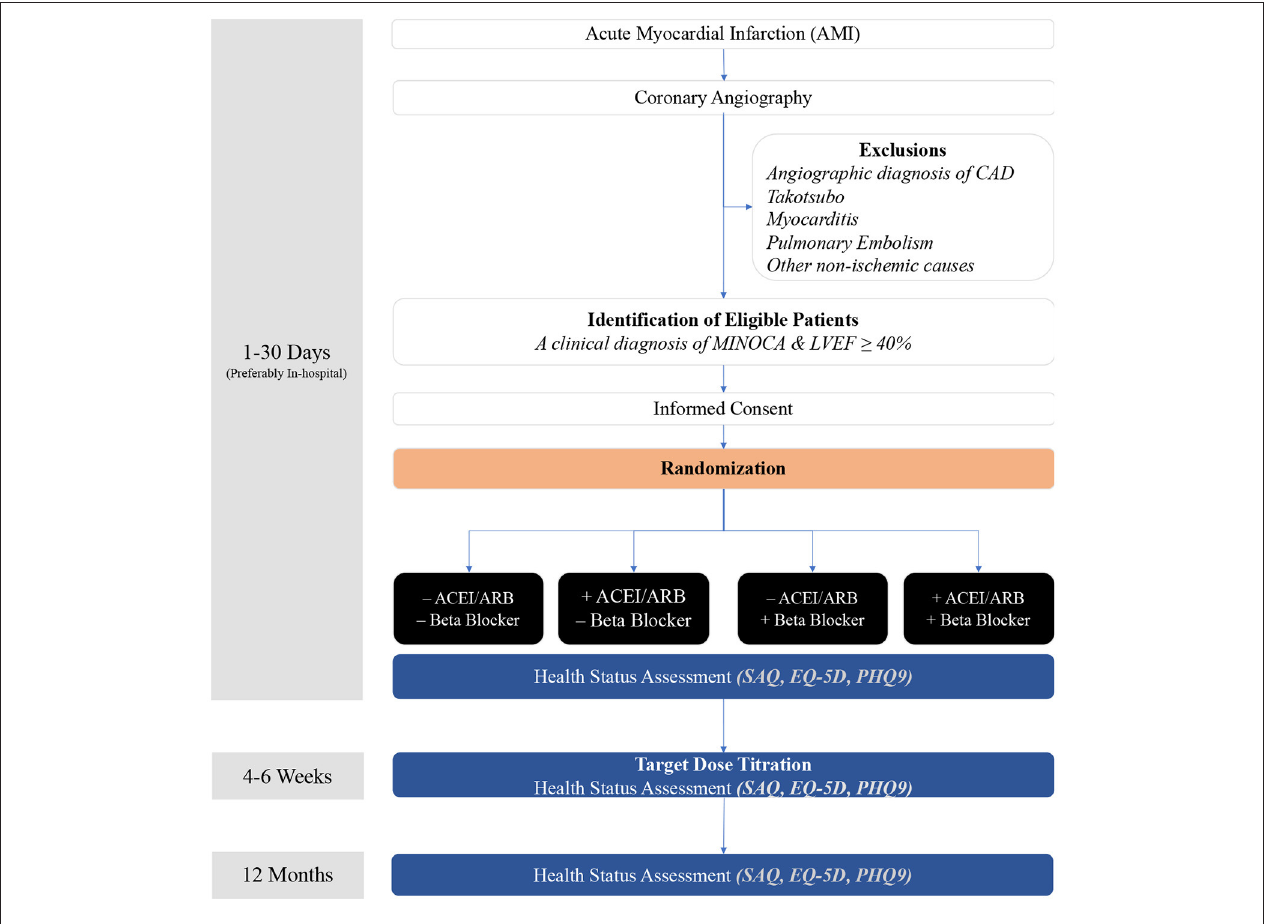
FIGURE 1 | Study flow chart.